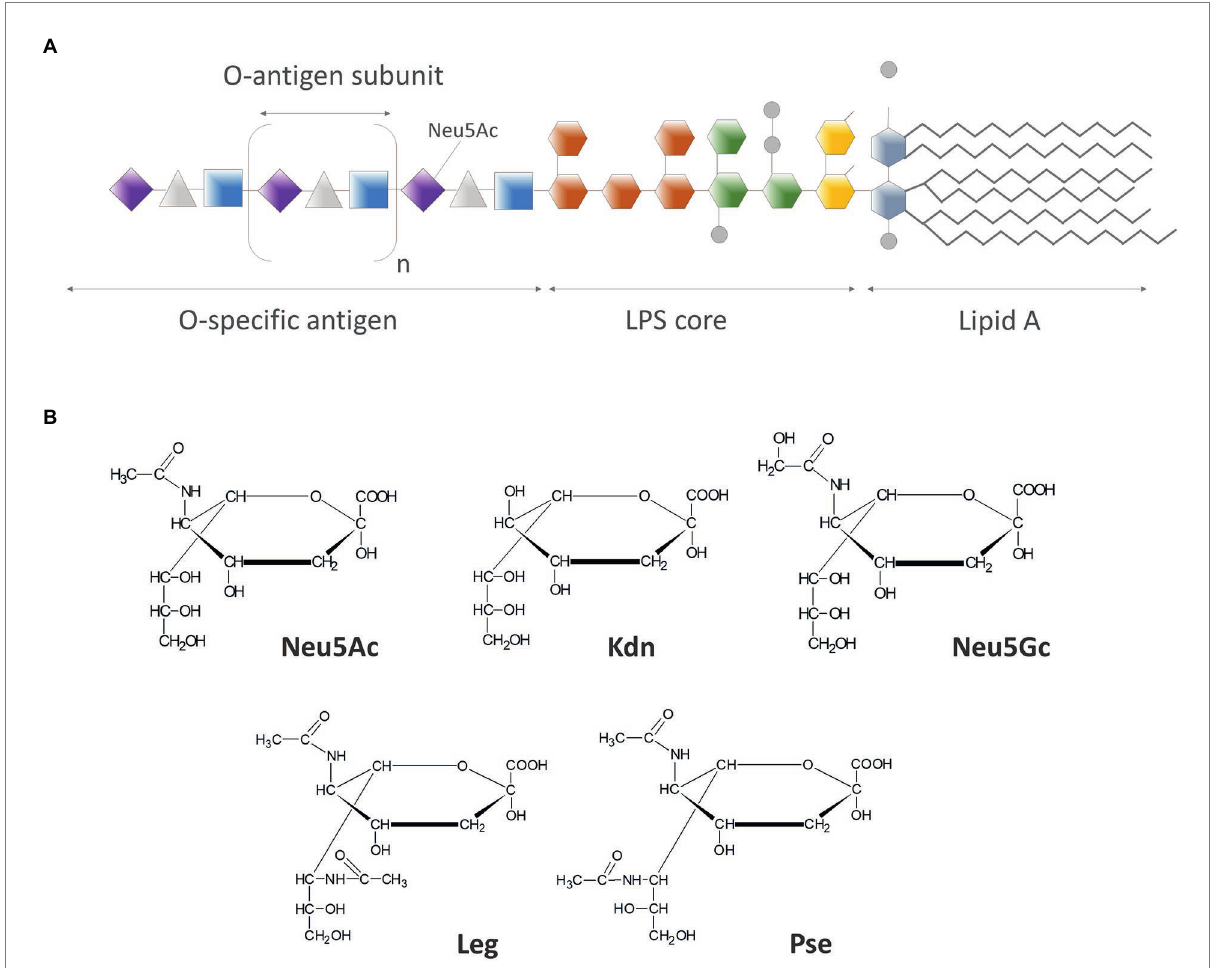
FIGURE 1 (A) Schematic structure of LPS molecule: O-specific antigen chain has a variable length, thus the amount of sialic acid residues per LPS molecule can vary from none (in rough LPS) up to over one hundred (in so-called very-long-O-antigen LPS); (B) Chemical structures of most common members of neuraminic acids family: N-acetylneuraminic acid (Neu5Ac), 2-keto-3-deoxy-nonulosonic acid (Kdn), N-glycolylneuraminic acid (Neu5Gc), legionaminic acid (Leg), and pseudaminic acid (Pse), presented in simplified Fisher projection